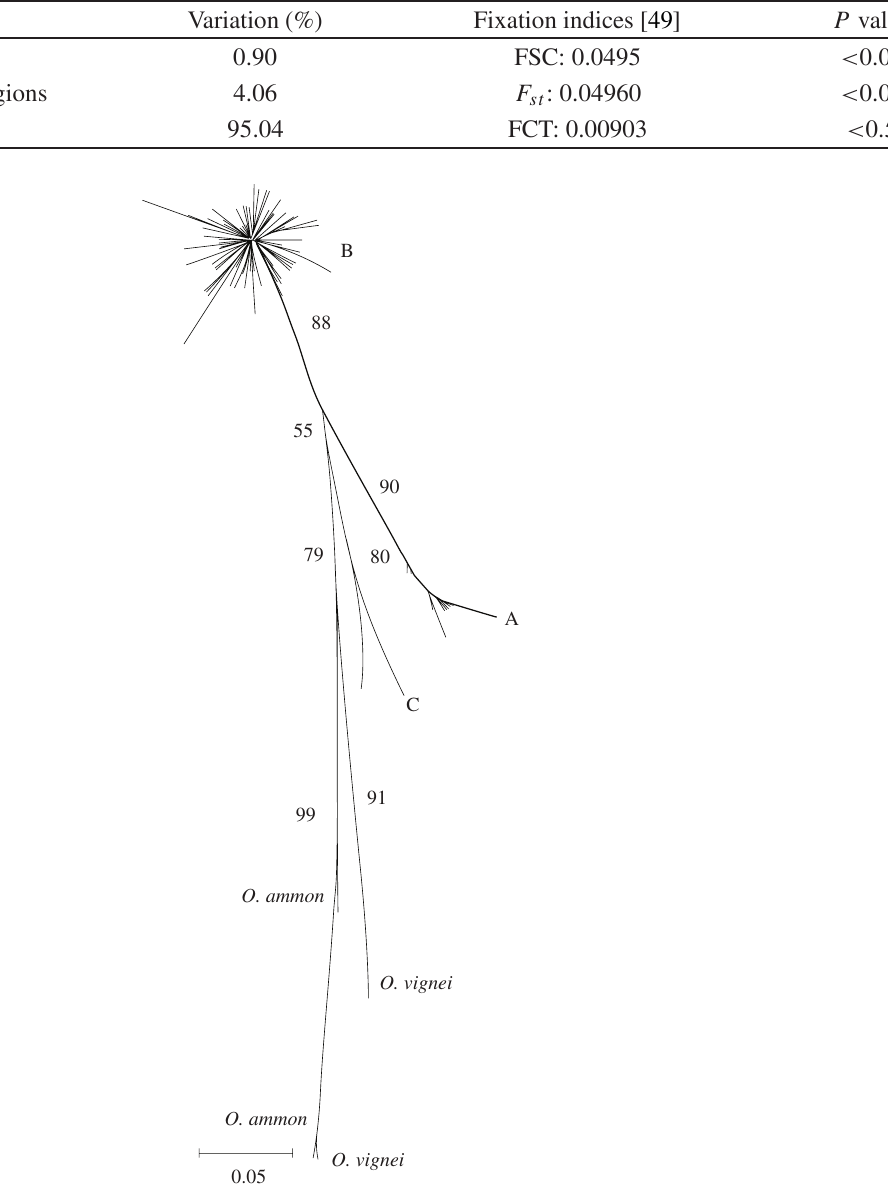
TABLE 4: Hierarchical analysis of molecular variance (AMOVA) with 10,000 permutations.